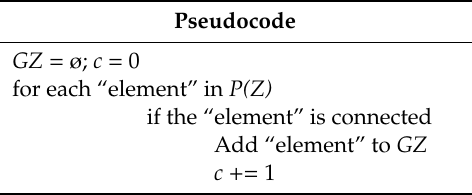
Table 1. Pseudocode for the Group of Zones GZ